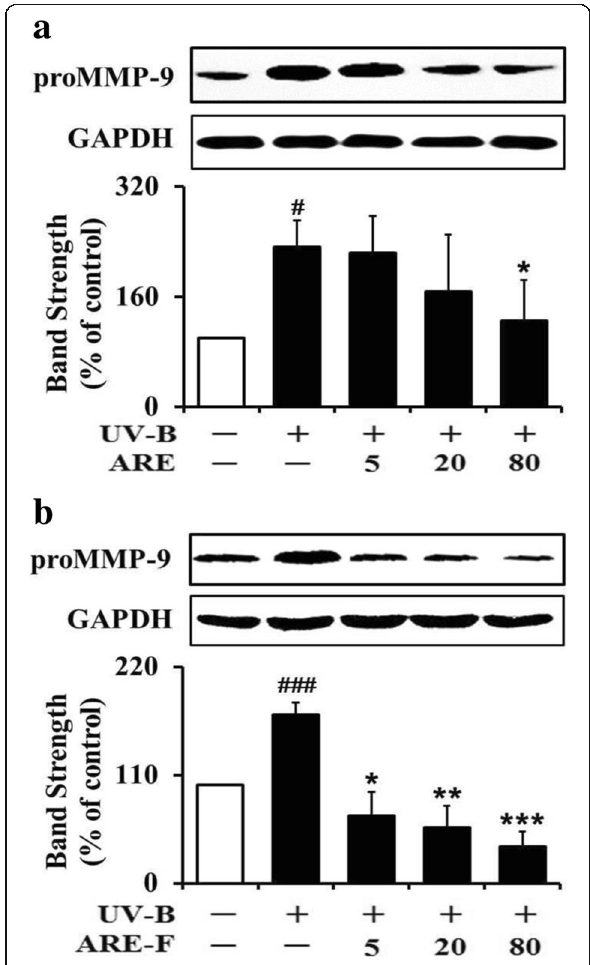
Fig. 2 Suppressive effects of ARE ( a ) and ARE-F ( b ) on the proMMP-9 elevation in HaCaT keratinocytes under UV-B irradiation. HaCaT cells were subjected to the varying concentrations (0, 2, 20 and 80 μ g/mL) of ARE ( a ) and ARE-F ( b ) for 1 h before the irradiation. The proMMP-9 proteins in cellular lysates, detected using western blotting analysis, were expressed as a percentage (%) of the corresponding non- irradiated control. In the lower panels of both a and b , the band strength was determined with densitometry using the ImageJ software which can be downloaded from the NIH website. # P < 0.05; ### P < 0.001 versus the non-irradiated control. * P < 0.05; ** P < 0.01; *** P <0.001 versus the non-treated control (UV-B irradiation alone)